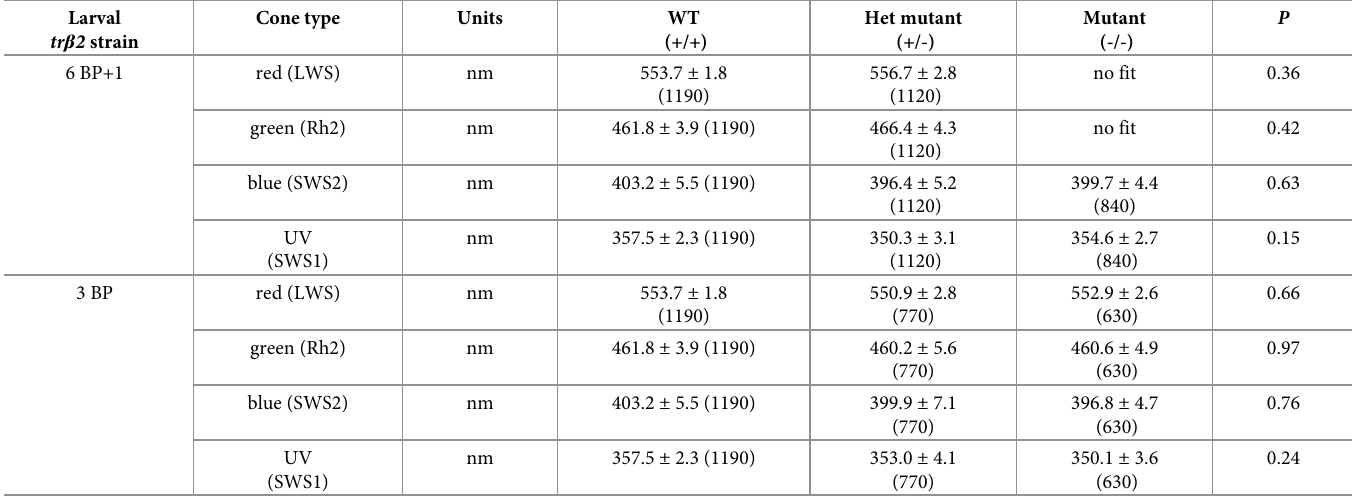
Table 1. Peak sensitivities of larval cones in tr β 2 genetic strains.